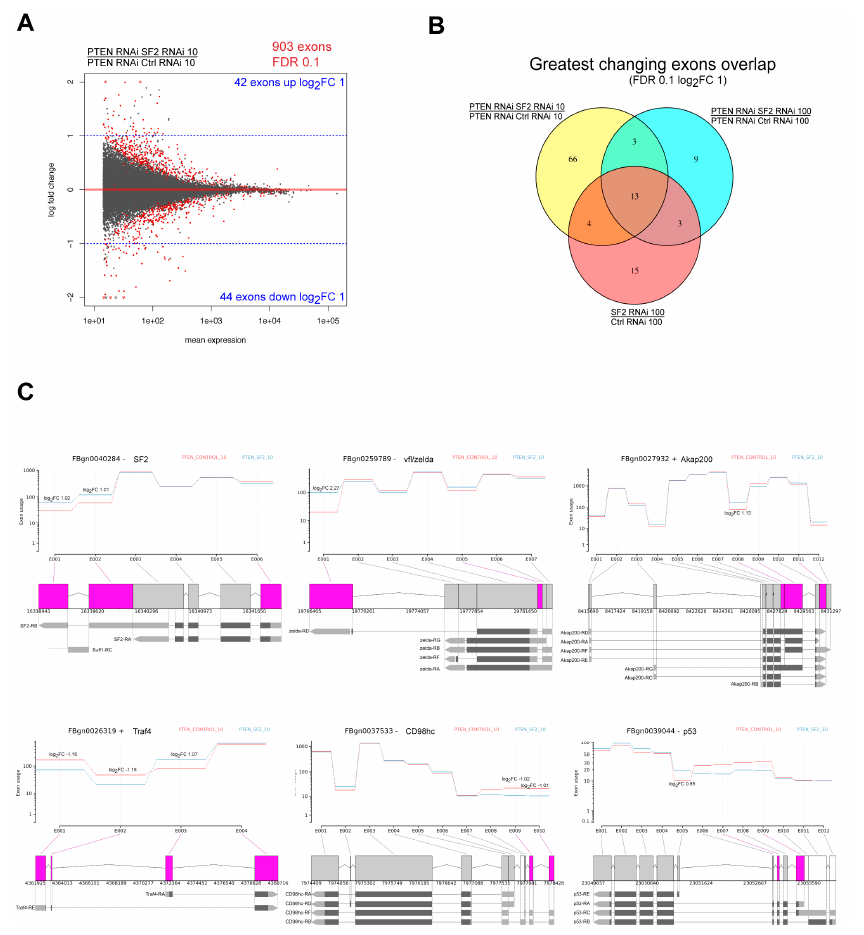
Figure 6. SF2 splicing targets in Pten- deficient tissues upon NR. ( A ) Upregulated and downregulated exons in Pten -deficient SF2 -deficient eye imaginal discs upon NR (FDR 0.1). ( B ) Overlap of genes with exon changes detected in PTEN RNAi SF2 RNAi 10 g/l PTEN RNAi SF2 RNAi 100 g/l and SF2 RNAi 100 g/l. ( C ) Chosen examples of SF2 splicing targets among top hits (FDR 0.1, |log 2 FC| 1). Pink shading shows changes with FDR <0.1. Note strand orientation, “+” or “ − ” after FBgn identifier for gene direction. DEXSeq does not detect exons per se, but “counting bins”, where an exon of variable length gets split into two bins (e.g., vertical line between “E002” and “E003” in SF2 plot), and does not consider overlapping genes separately (e.g., in SF2 plot, what the software depicts as an intron between “E001” and “E002” is actually the first exon of a neighboring gene). Transcript schemes according to FlyBase.